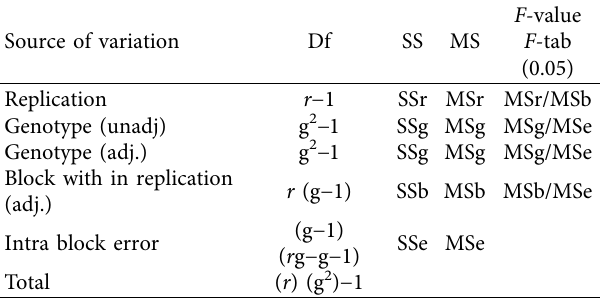
Table 2: Analysis of variance skeleton for a year. Source of variation Df